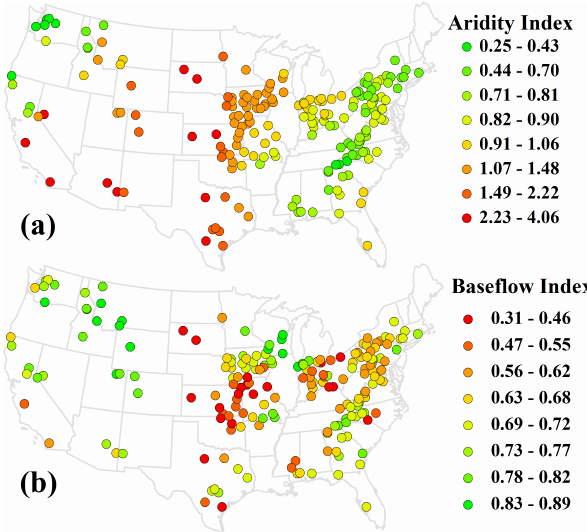
Fig. 1. Distribution of 197 MOPEX catchments and spatial variabil- ity of (a) aridity index (AI) and (b) baseflow index